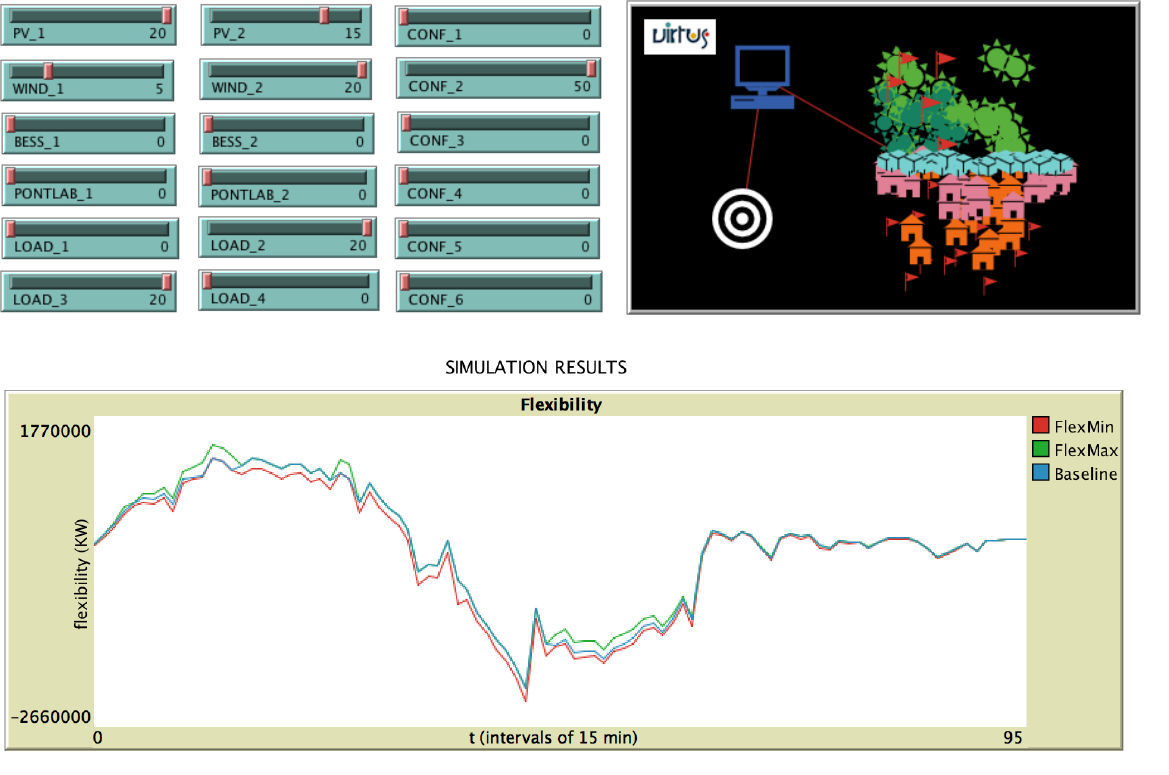
Figure 19. ( Up ) Case study 3 setting. ( Down ) Case study 3